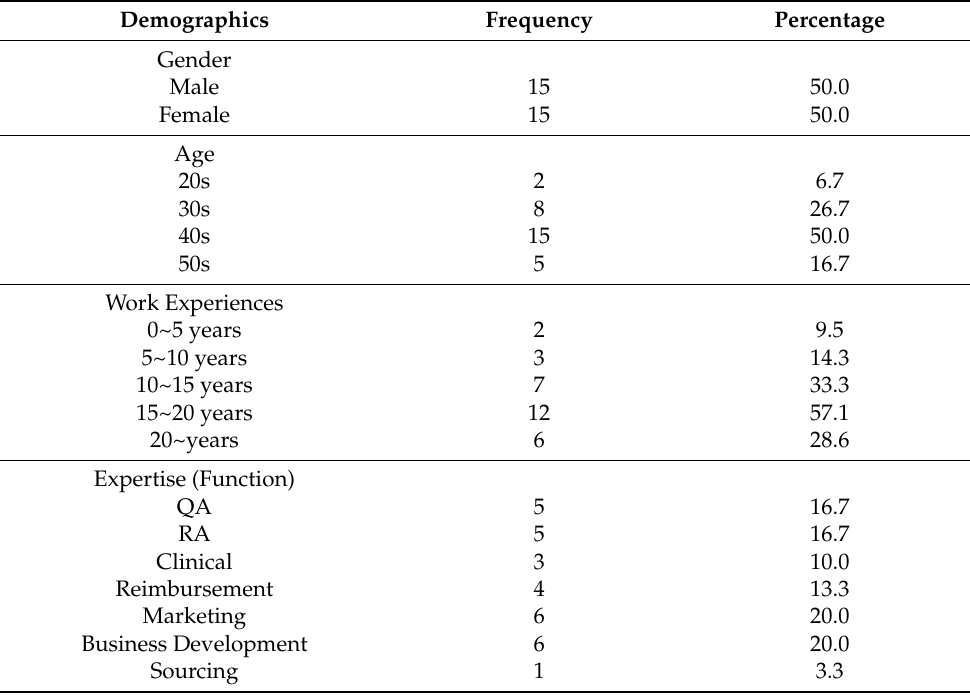
Table 1. Survey respondent